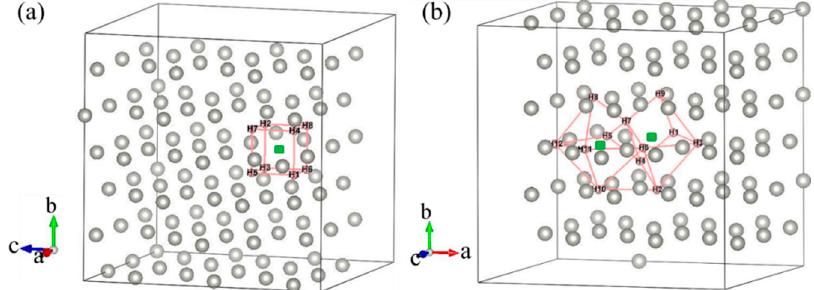
Figure 2. Structure diagram of H dissolved in monovacancy ( a ) and divacancy ( b ) defects of fcc-Pd. The sequence of H bonding positions is shown.